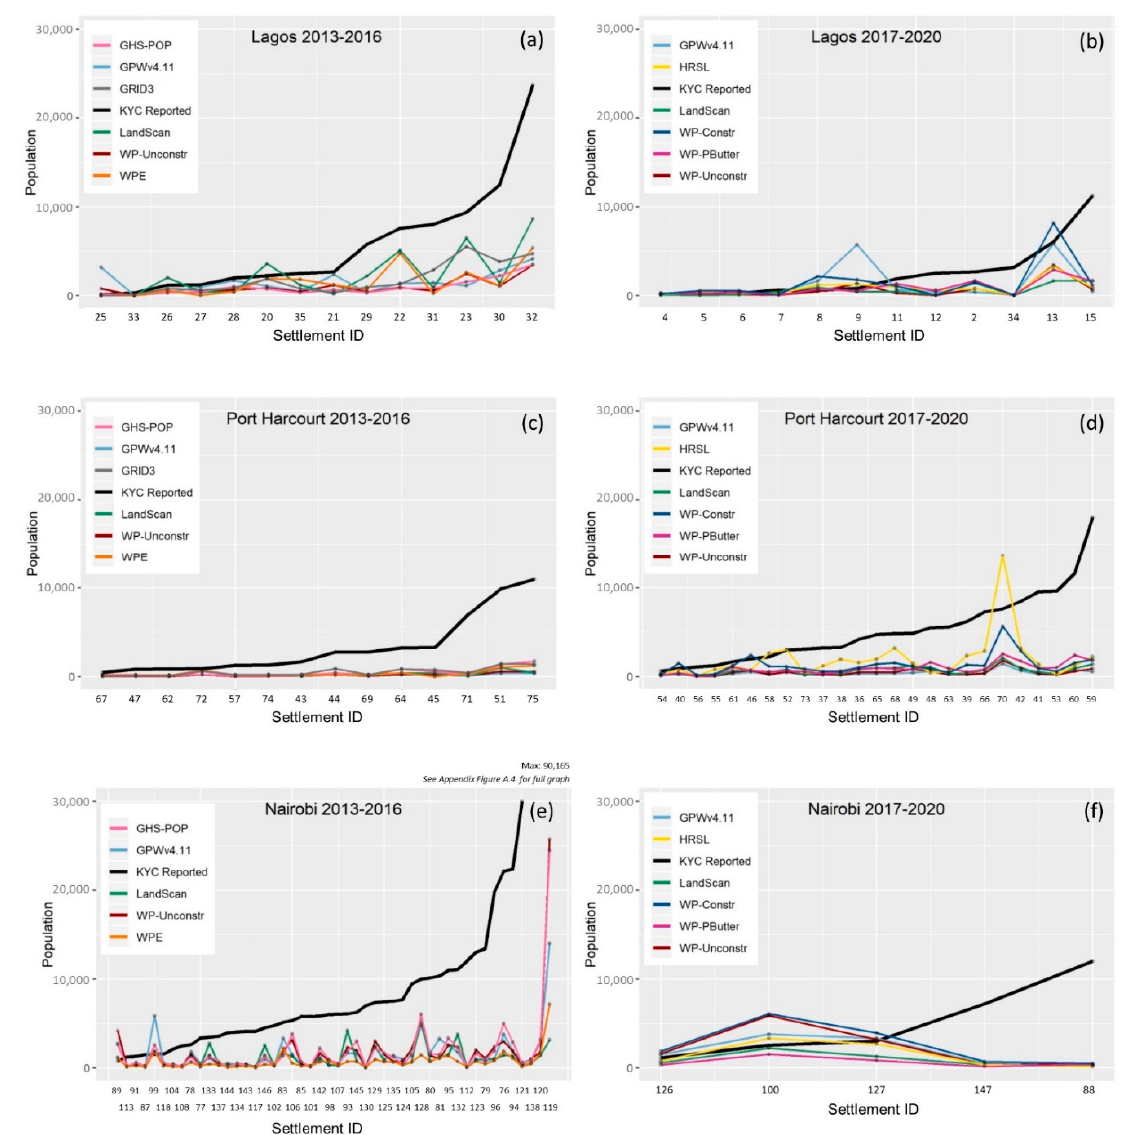
Figure 5. Know Your City reported population versus gridded population estimates in 118 slum settlements across Lagos (Nigeria), Port Harcourt (Nigeria), and Nairobi (Kenya). Only gridded population estimates and KYC reported populations aligned in the same time period are reported. Population comparisons in ( a ) Lagos 2013–2016, ( b ) Lagos 2017–2020, ( c )